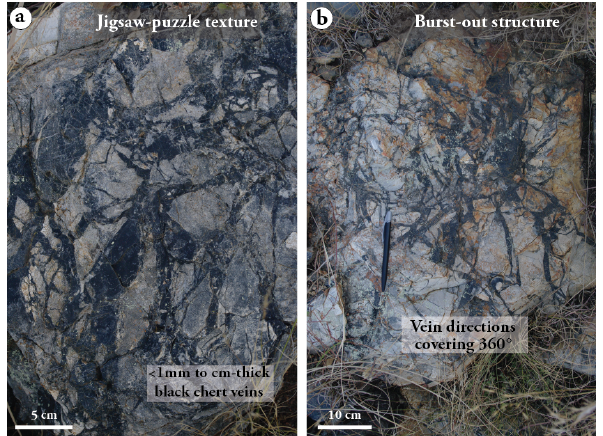
Figure 7. Hydraulic-fracturing features in Barite Valley dikes. (a) Jigsaw-puzzle texture showing in situ brecciation: angular country rock fragments are little displaced and separated by millimetre- to centimetre-thick black chert veins. (b) Randomly distributed black chert veins covering 360 ◦ directions around a central, highly frac- tured zone.